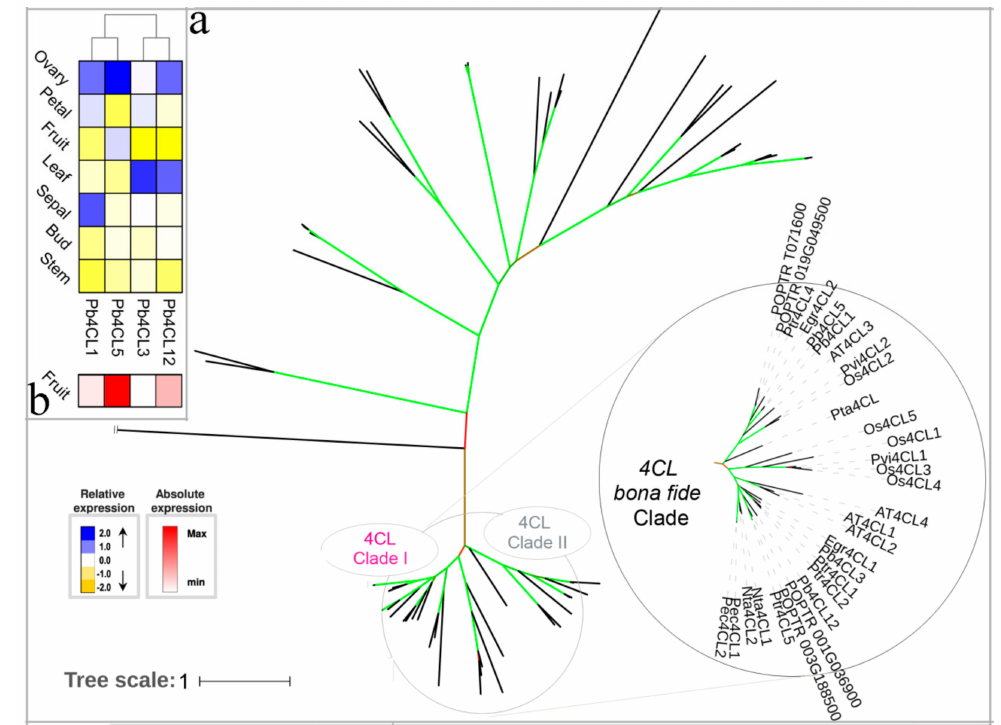
Figure 5. Phylogenetic tree and expression profiles of the 4CL bona fide clade. ( a ) ML tree built with 4CL bona fide enzymes from several species. ( b ) The expression profiles P. bretschneideri 4CL bona fide genes. Subclade containing the bona fide genes is highlighted. The green color of the tree branches suggests strong node support (bootstrap support ≥ 95% and SH-aLRT ≥ 75%). The FPKM values of Pb4CL genes in di ff erent tissues are indicated in Table S3. The gene accession number is indicated in Table S4, Figure S1. The tree scale is the number of amino acid substitution per